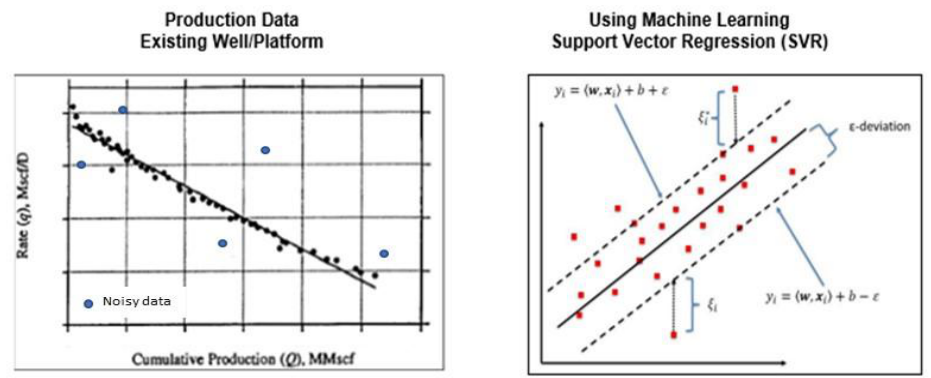
Figure 6—An example of SVR method for removing noisy data (Doan and Vo 2019b)